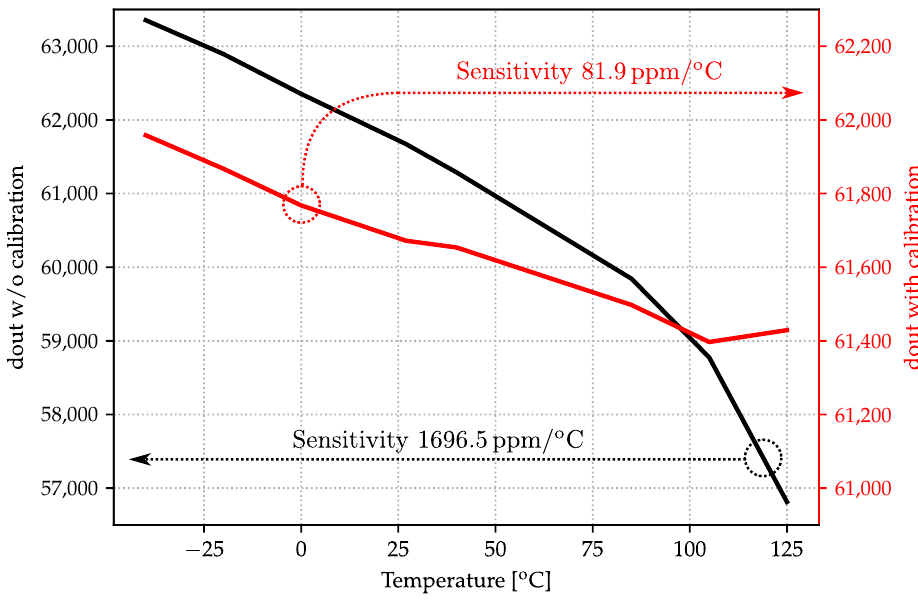
Figure 11. CDC output temperature sensitivity before and after one-point